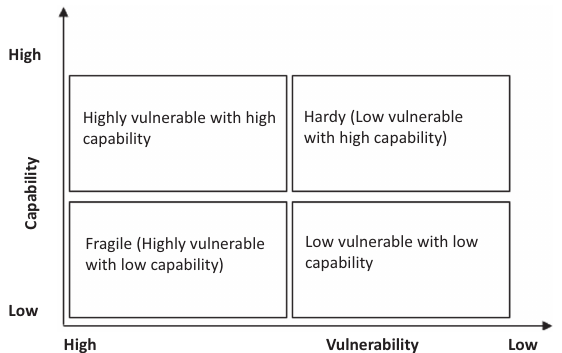
Figure 2. Matrix for measurement of